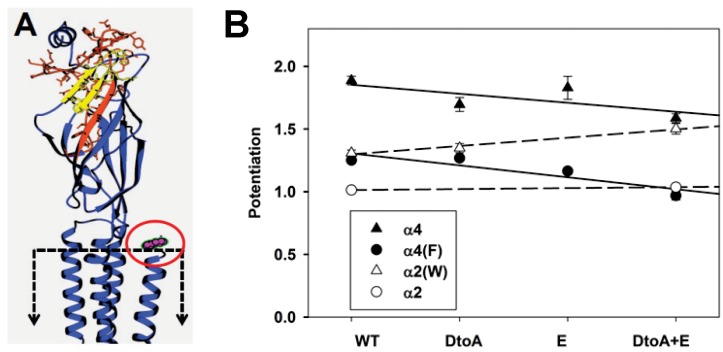
The effects of N-terminal chimeras on potentiation.Panel A shows a homology model of the α4 subunit (see Methods). A single subunit is shown, with the ion channel to the left and the extracellular solution at the top. The approximate location of the membrane is shown by the dashed box, note that the membrane spanning region is truncated in this view. The D to A loop region (MMT(57) to IVL(97)) is shown in red with amino acid side chains shown in stick representation, while the E loop (VTH(109) to QWT(124)) is shown in yellow. The carboxyl terminal region is shown in magenta and indicated by the red oval. In aligning the α4 subunit to sequence in the GluCl structure, the last amino acid in the structure aligned with the leucine in α4, so the AGMI residues are not shown. Note that the regions exchanged are far from the membrane and the C-terminal domain, but include portions of the ACh-binding site. Panel B shows potentiation for the different chimeras. The chimeric regions interchanged are indicated along the abscissa; chimeras were constructed on the α4 (filled triangles) and α4(F) (filled circles) subunits inserting sequence from the α2 subunit. Homologous transfers were made by transferring sequence from the α4 subunit into the α2 (hollow circles) and α2(W) (hollow triangles) subunits. The lines through the points for points show the lines predicted by linear regression on the source of the inserted region (see Methods). The slopes are -0.072 for chimeras on α4 and -0.095 on α4(F), and 0.008 for α2 and 0.066 for α2(W). None of the slopes differ significantly from 0 (P > 0.09). However, as shown in Table 5 in all cases the potentiation of receptors containing α4(DtoA+E) regions was significantly larger than those containing the homologous α subunits containing α2(DtoA+E) regions. Data values are given in Table 5.